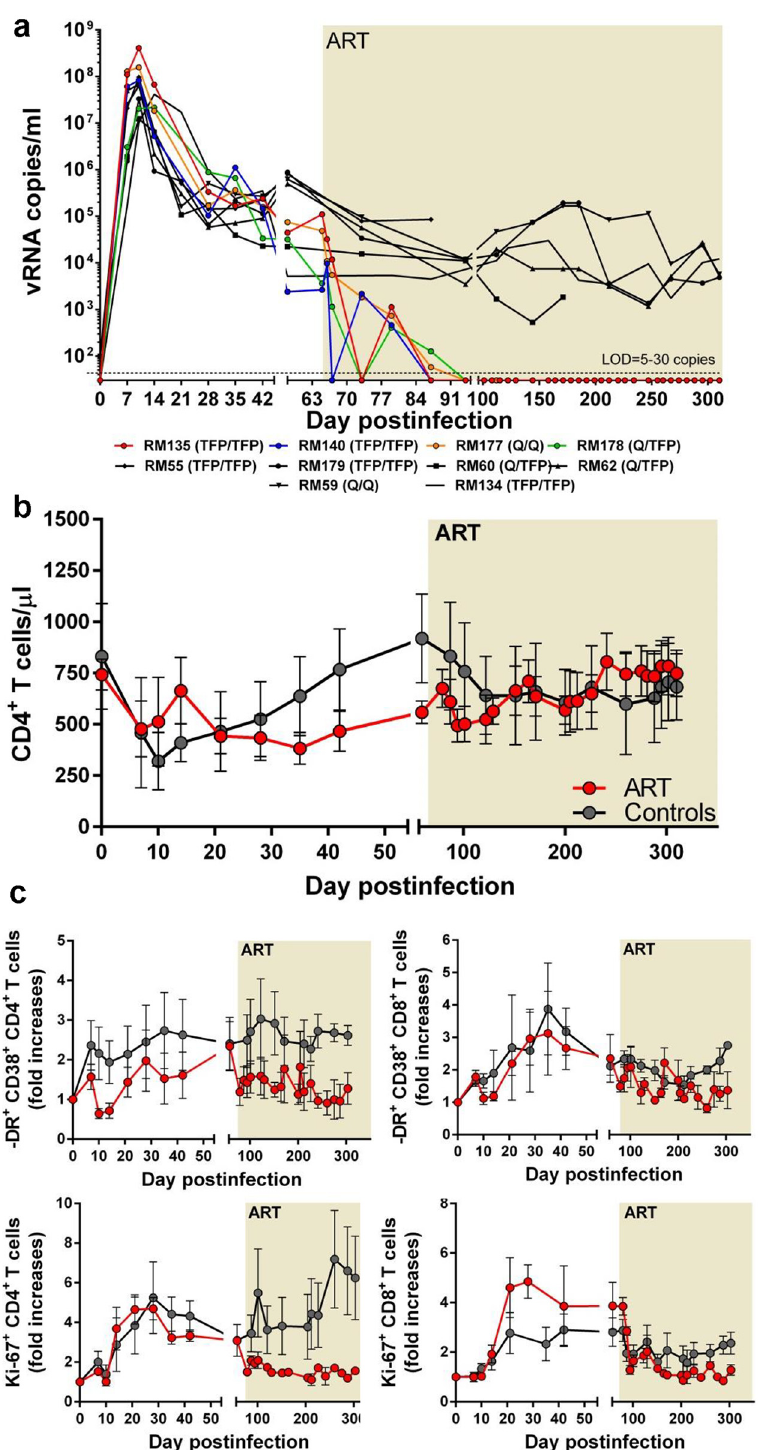
Fig 2. SIVsmmFTq infection of RMs can be completely controlled with conventional antiretroviral therapy (ART). (a) Comparative dynamics of viral replication between RMs in the control group (black symbols and lines) and the RMs receiving a combination ART (PMPA + FTC + L-870812) for a duration of > 9 months (treated animals are color-coded, as shown in the legend). (b) Comparison of the changes in peripheral CD4 + T cells between na ï ve RM controls (black lines and symbols) and RMs receiving ART